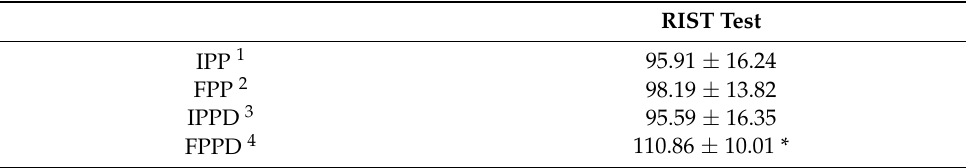
Figure 4. Evolution of results in RIST test between placebo and product groups in percentage increase or decrease. * indi- cate significant differences. ( p < 0.05).